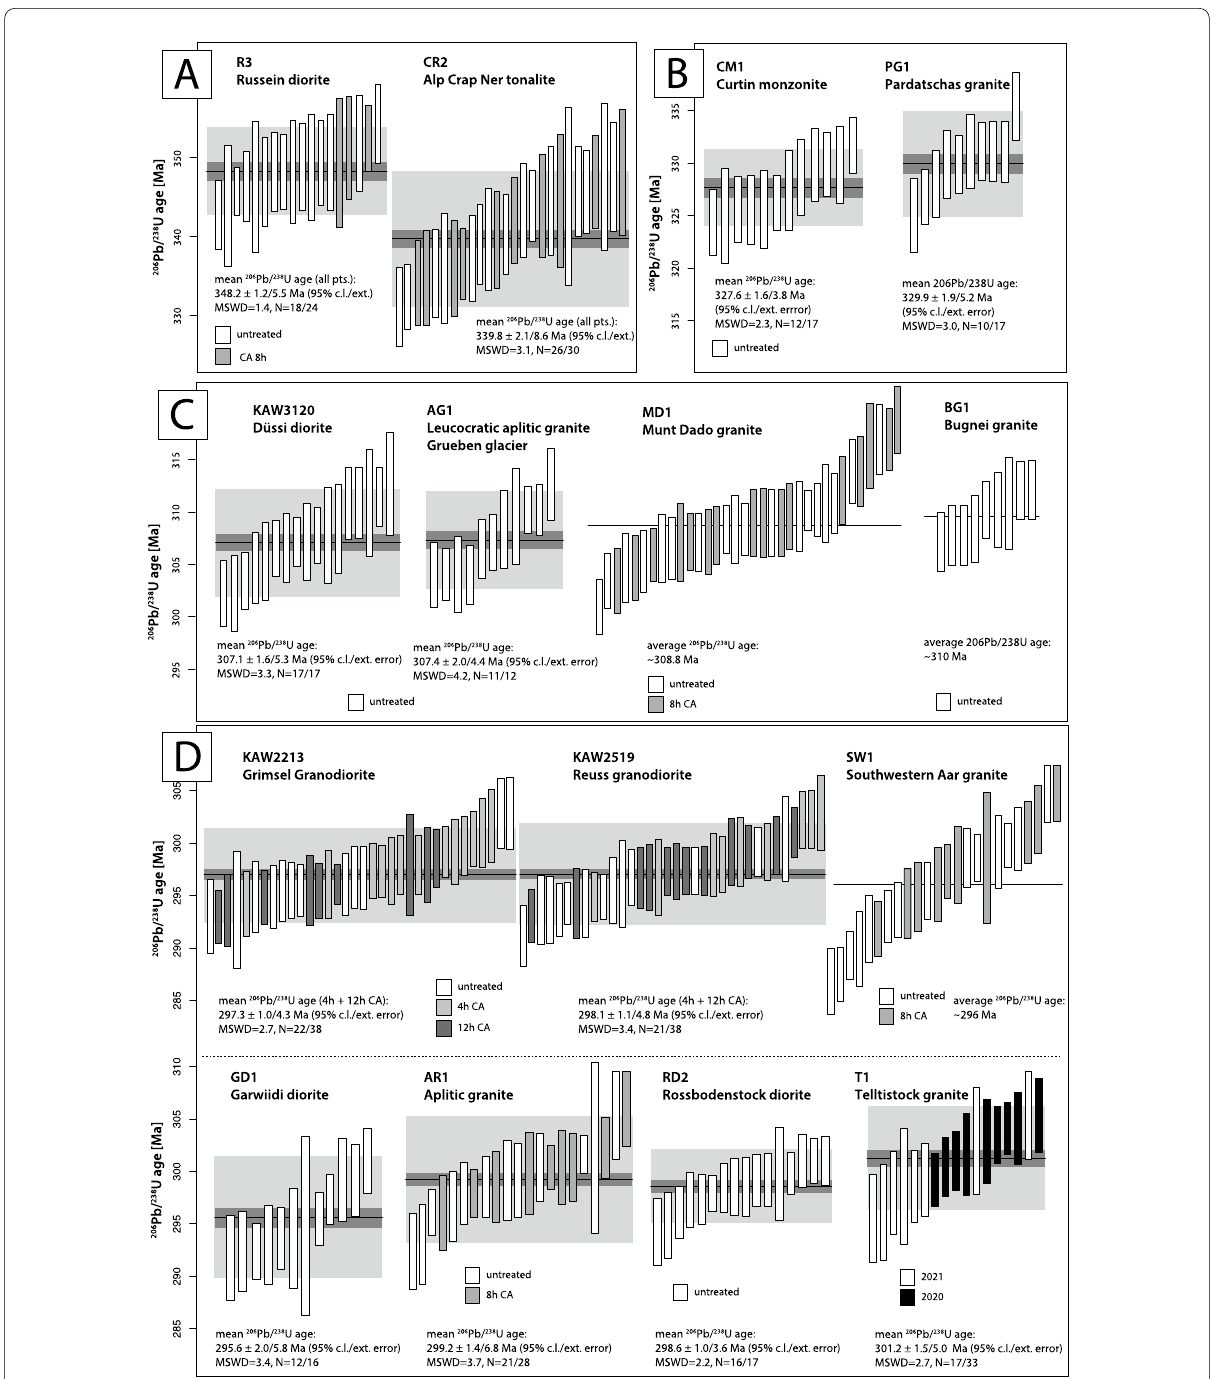
Fig. 3 Age-ranked order plots of LA-ICP-MS dates: A Pre-Carboniferous intrusions/Surselva group; B Samples of Group A/Rötifirn group; C Samples of Group B/Fruttstock group; D Samples of Group C/Haslital